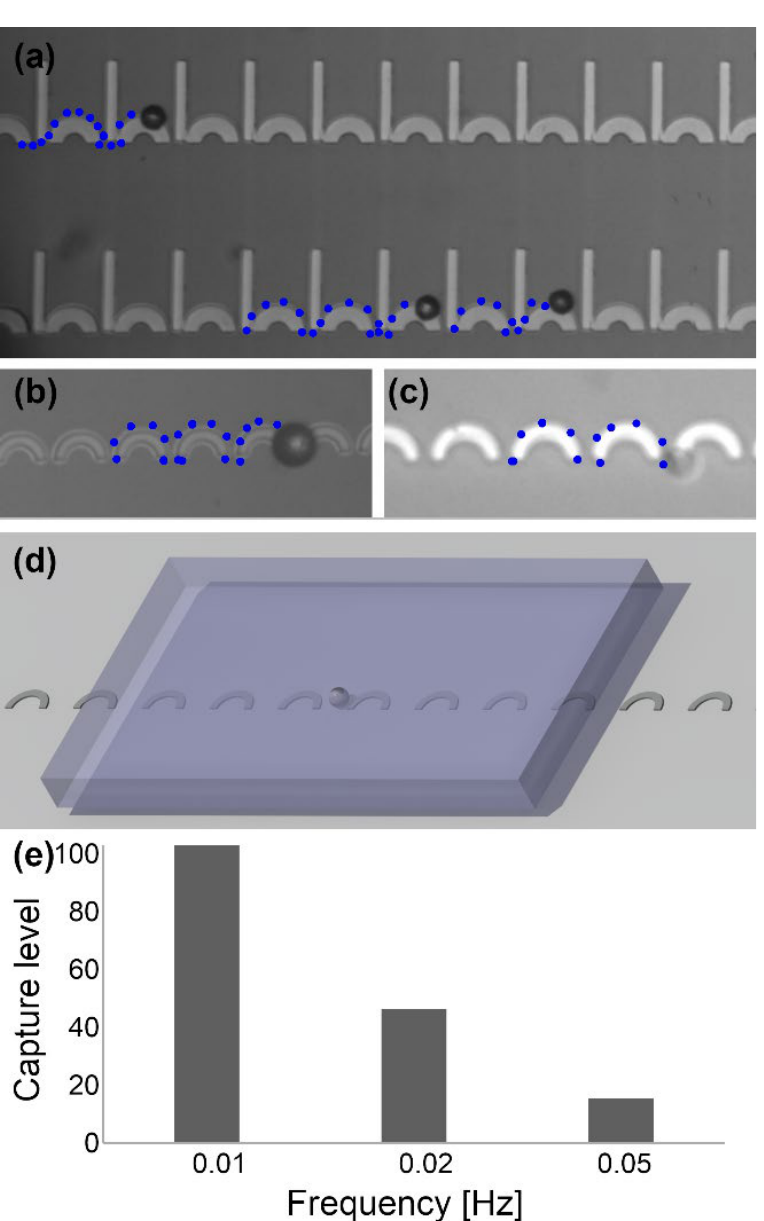
Figure 10. Sample microscopy images of particles transported along the ( a ) CI magnetic track and ( b ) C-shaped magnetic track are illustrated. ( c ) Magnetically labeled AML cells are transported on the proposed C-shaped magnetic track. A magnetic field with a conical angle of α = 45 ◦ (i.e., the in-plane and vertical field components are fixed at 50 Oe) at a frequency of 0.05 Hz, which is rotating clockwise is applied to the chip. The blue dotted lines depict the trajectories of the particles and cells. ( d ) A schematic showing a particle moving on the proposed magnetic track in an area containing the solution of interest. ( e ) mRNA capture levels for barcode-carrying magnetic beads being transported at various deriving frequencies.